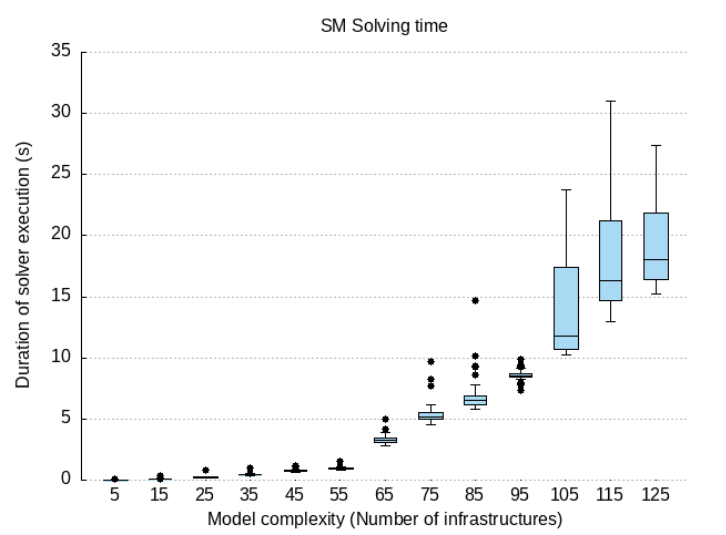
Figure 10. Measurements of solving duration compared to constraints model complexity.